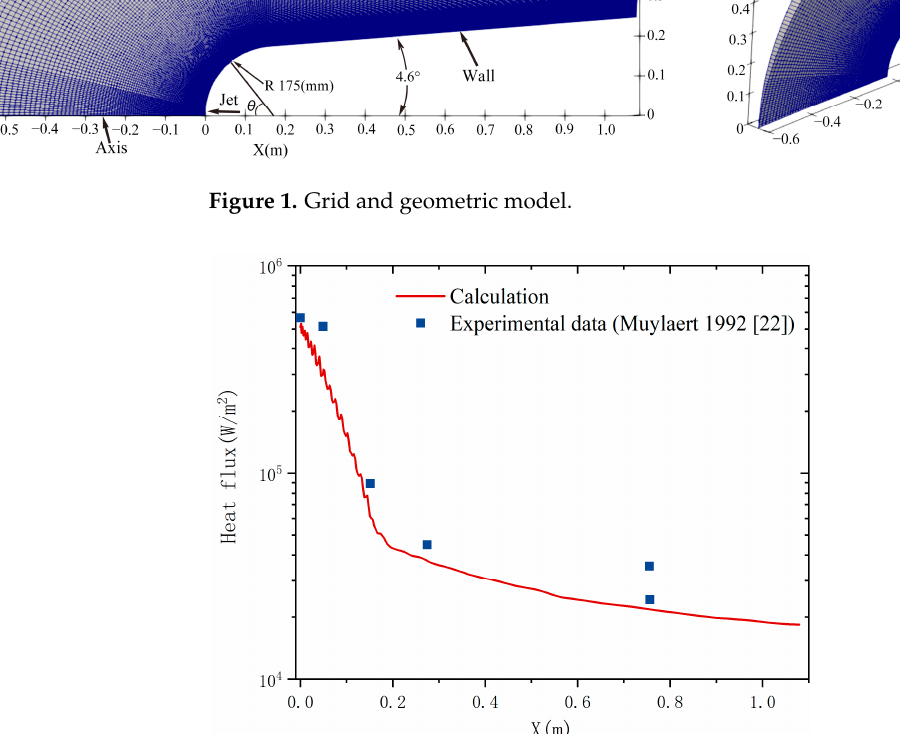
Figure 2. Comparison of heat flux obtained from the calculation and experiment.